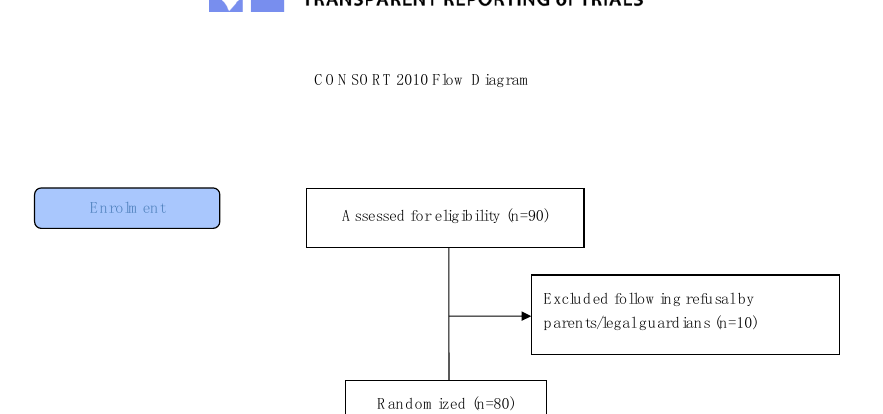
Figure 1. Flow chart of the randomized controlled trial according to CONSORT.